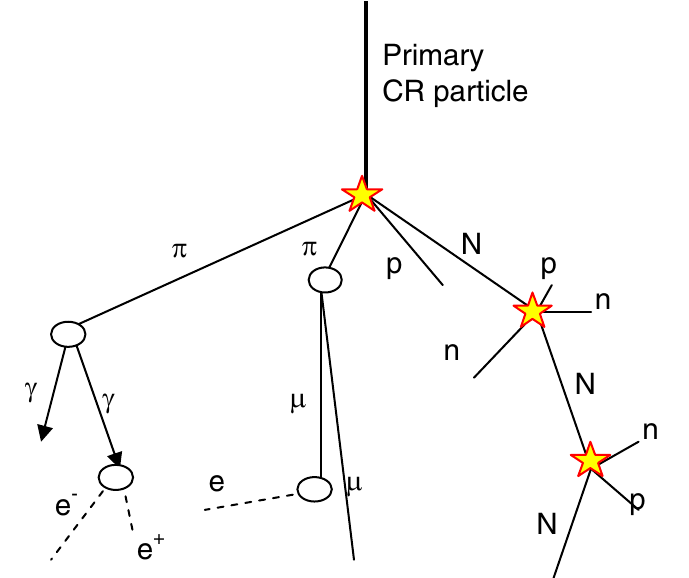
Fig. 6 Schematic view of an atmospheric cascade caused by energetic cosmic rays in the atmosphere. Left- to-right are denoted, respectively, the soft, muon and hadronic components of the cascade. Symbols “N, p, n, μ , π , e − , e + , and γ ” denote nuclei, protons, neutrons, muons, pions, electrons, positrons, and photons, respectively. Stars denote nuclear collisions, ovals —decay processes. This sketch does not represent the full development of the cascade and serves solely as an illustration for the processes discussed in the